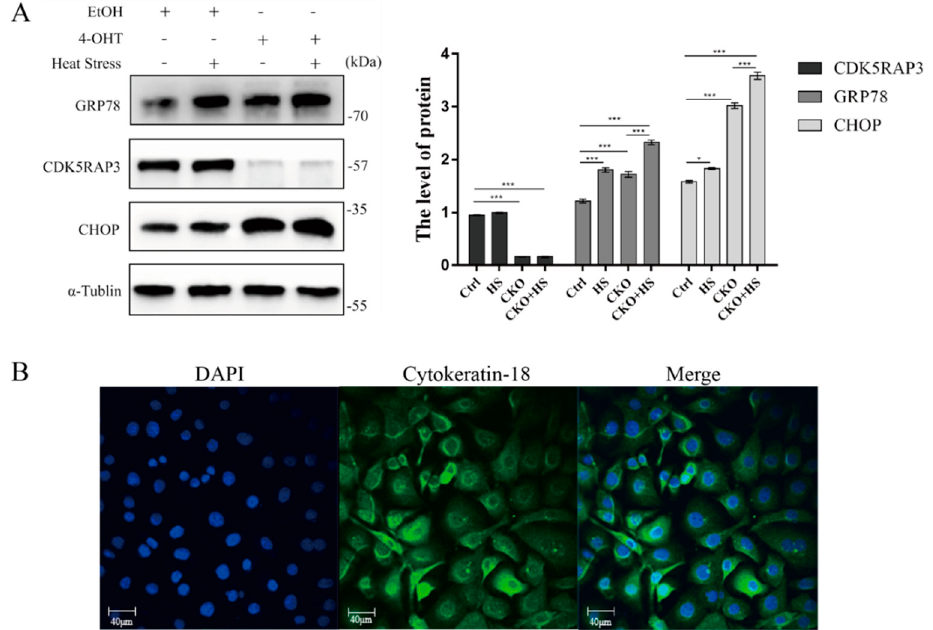
Figure 9. ( A ). Alteration in expression of GRP78 and CHOP due to deficiency of CDK5RAP3 and heat stress. Expression of ER stress marker genes protein accumulation of GRP78 and Chop in mammary gland of mice cultured under heat stress (42 ◦ C / 3 h) and corresponding the control (37 ◦ C). The BMECs were silenced by using the SiRNA of CDK5RAP3, marked as “ + ”. α -Tublin was used to normalize the expression of targets protein expression of GRP78 and Chop. ( B ). Identification of bovine mammary epithelial cells by immunofluorescence. DAPI is the staining of the nucleus, and the nucleus is blue light. Cytokeratin-18 is the localization of immunofluorescence expression of keratin-18, a protein specific to epithelial cells. Merge is a synthesis diagram of the cytoplasm and nucleus. * p < 0.05, *** p < 0.001.